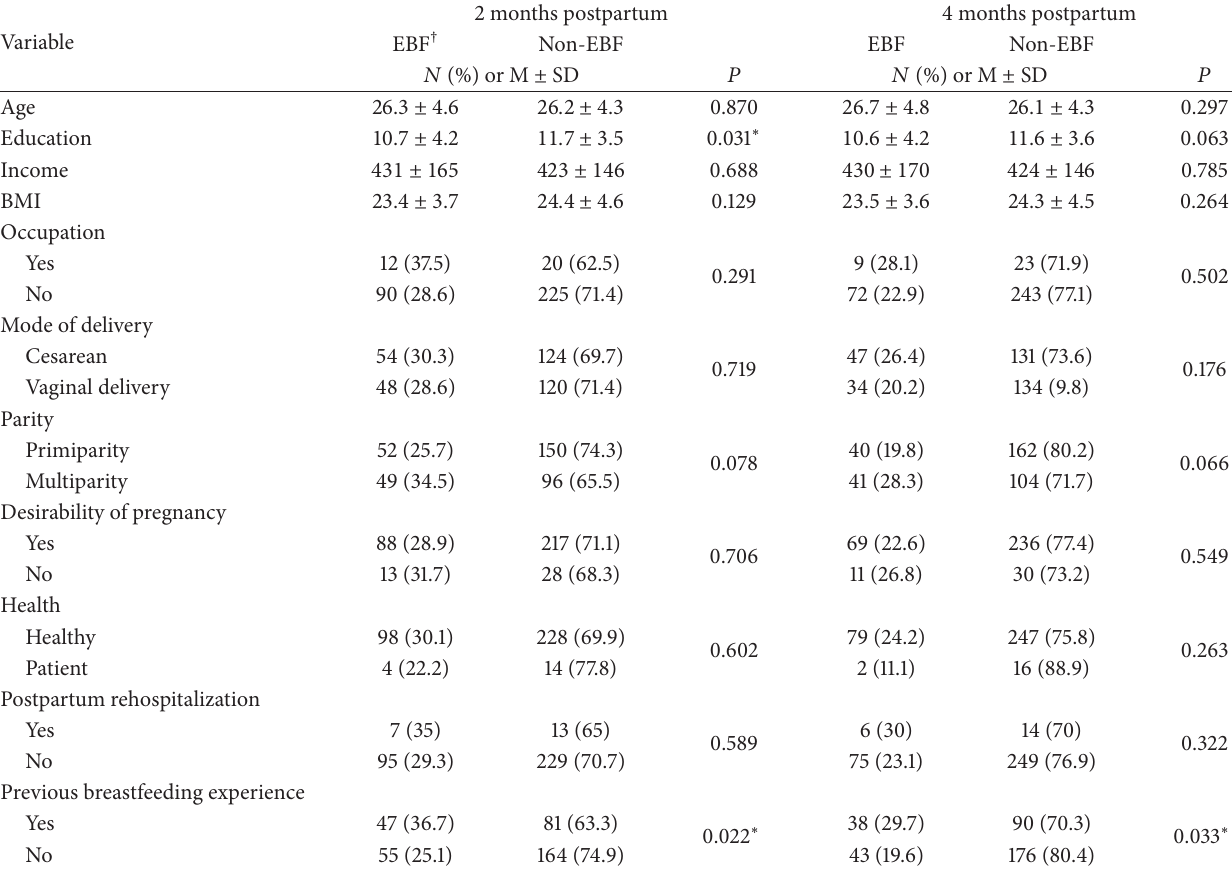
Table 1: Women’s characteristics based on breastfeeding practices.